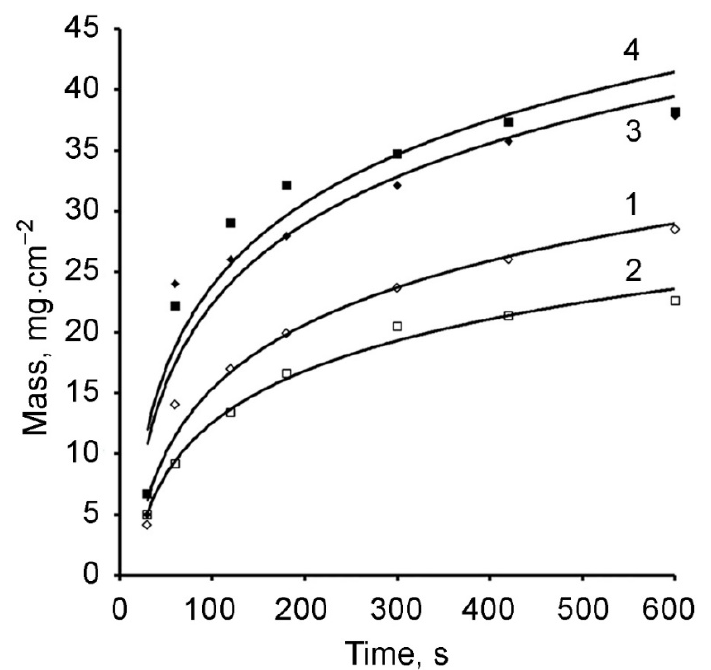
Figure 9. Dependence of the polymer mass on the electropolymerization time: electrolyte 1 (1), electrolyte 2 (2), electrolyte 3 (3), electrolyte 4 (4).